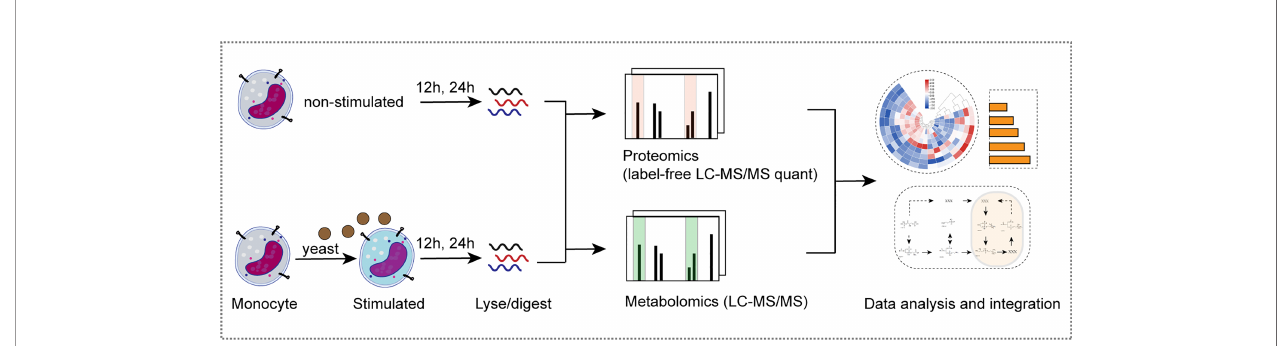
FIGURE 1 | Multi-omics analysis of monocytes stimulated by C. albicans . Schematic view of the experimental investigation of monocytes stimulated by C. albicans .